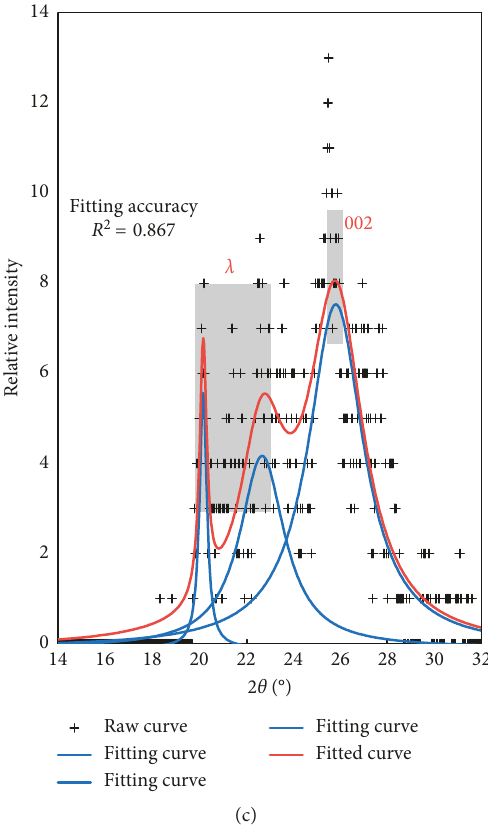
Figure 8: In situ XRD curve fitting results of the HB coal sample at different temperatures: (a) 300 ° C; (b) 600 ° C; (c) 900 °